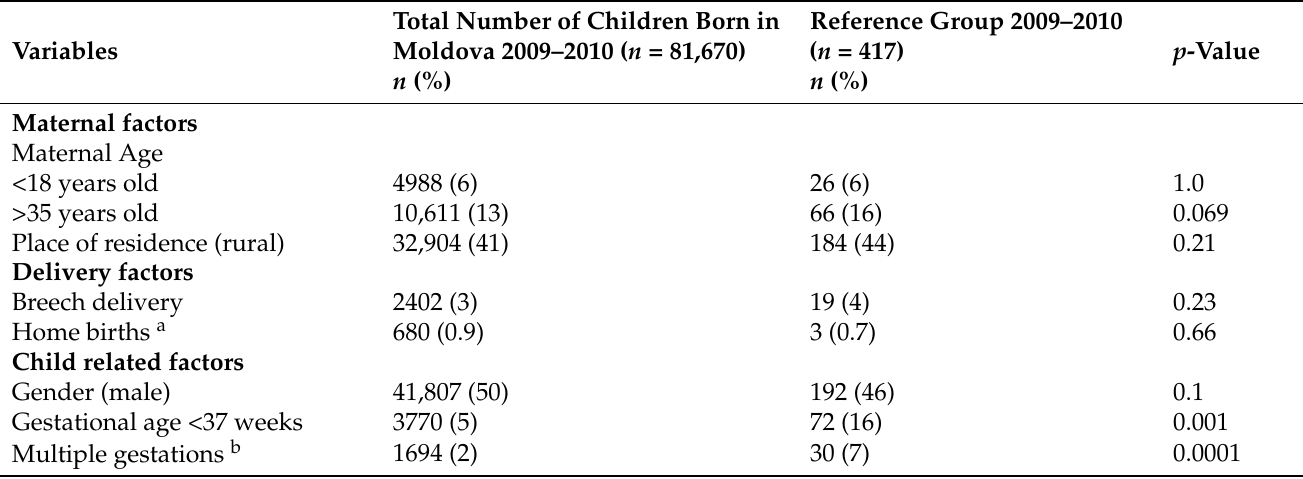
Table 1. Reference group